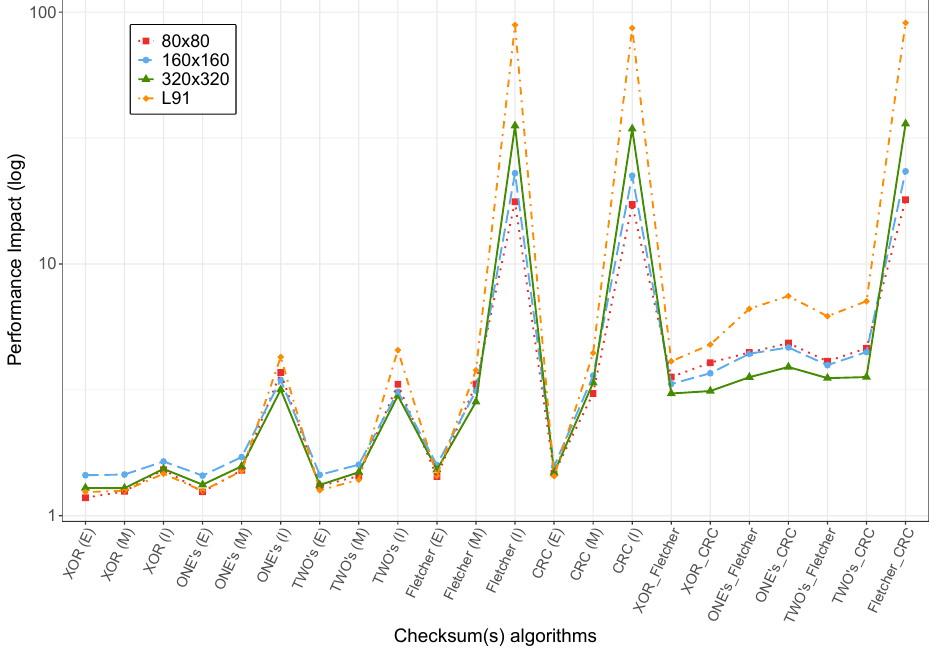
Figure 6. Performance impact with -O3